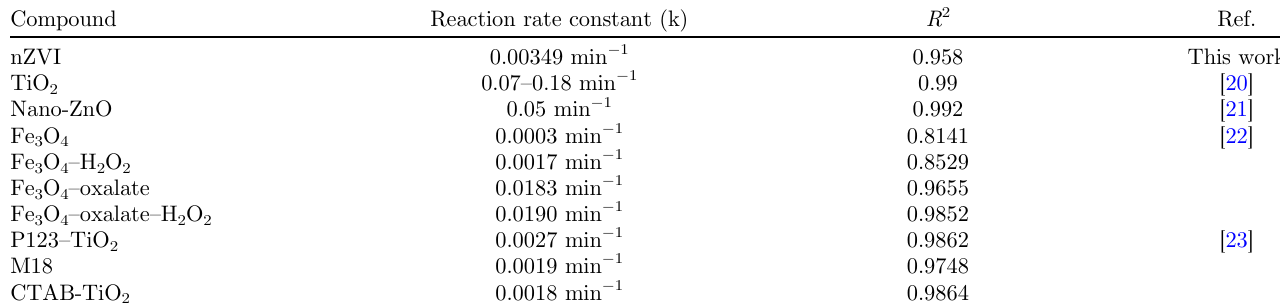
Figure 6. The photoluminescence spectra of Zero-valent iron nanoparticles. Table 1. A comparative study of the reaction rate constant employing different photocatalyst. Compound Reaction rate constant (k) R 2